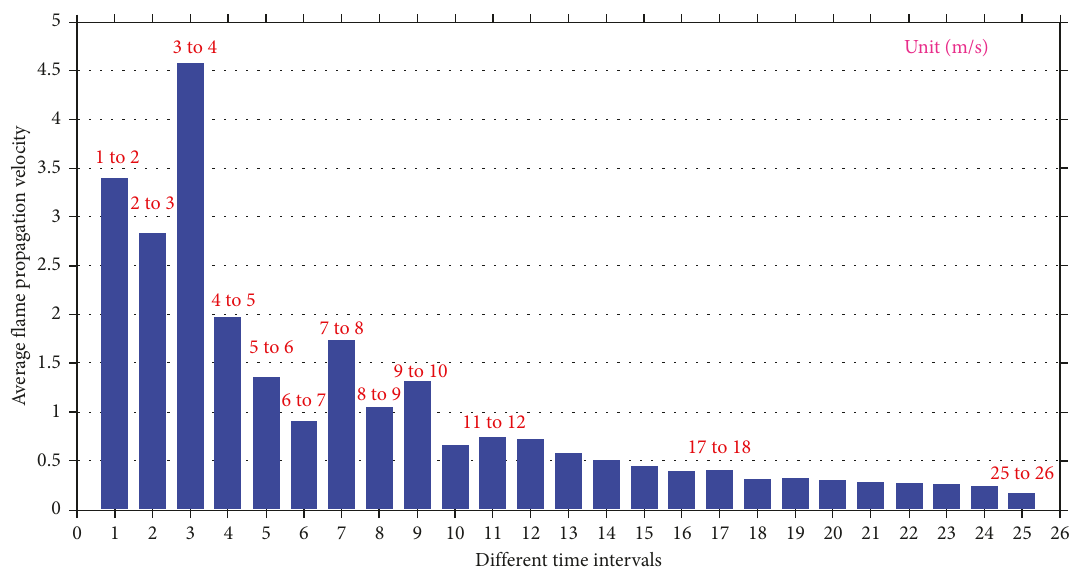
Figure 5: Flame propagation velocity of deflagration in the